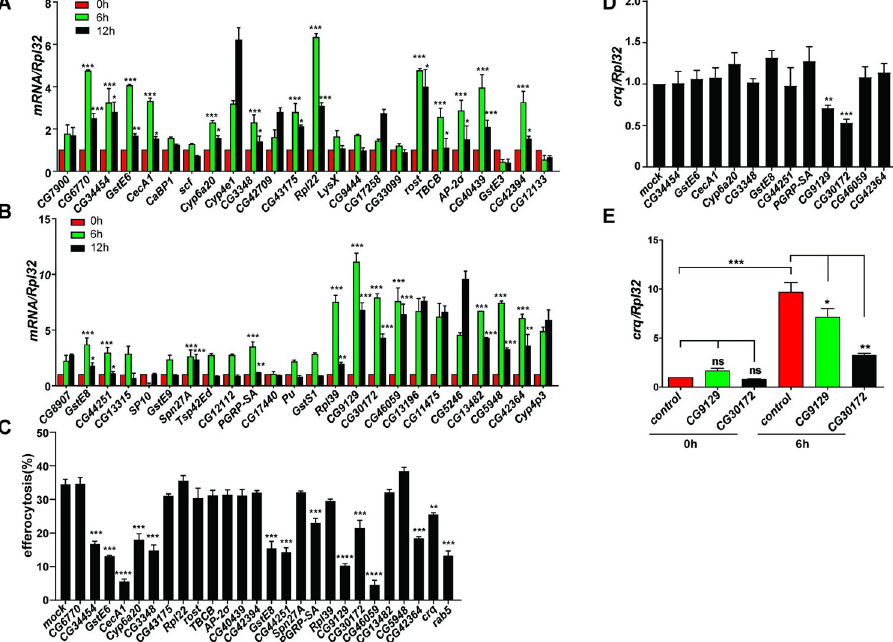
Fig 2. CG9129 is involved in efferocytosis and regulates crq expression in vitro . A and B . The transcription levels of differentially expressed genes determined by the transcriptomic analysis were validated by qPCR in S2 cells incubated with ACs for 0, 6, and 12 h. Twenty-four genes showed expression patterns similar to that of crq . The data were collected from three independent experiments; 0 h S2 cells were used as the control. The asterisks above the column of the 6 h time-point denote a significantly higher gene expression than that detected at 0 h. The asterisks above the column of the 12 h time-point denote a significantly lower gene expression than that detected at 6 h. C. Efferocytosis efficiency of RNAi-treated S2 cells after 6 h co-incubation with ACs. Each of the identified 24 genes was knocked down individually. The data are representative of three independent experiments. Significant differences were observed in comparison with mock RNAi-treated S2 cells (negative control), or crq and Rab5 RNAi-treated S2 cells (positive controls). D. The crq mRNA levels were quantified by qPCR in RNAi-treated S2 cells showing decreased efferocytosis during 6 h incubation with ACs. The data are relative to the expression determined in mock RNAi-treated S2 cells. E. The relative crq mRNA levels were also quantified by qPCR in control, CG9129 knockdown, and CG30172 knockdown S2 cells in the absence (0 h) or presence of ACs (6 h incubation). Statistical analysis was performed using the two-way ANOVA (A-B, E) or one-way ANOVA (C-D)